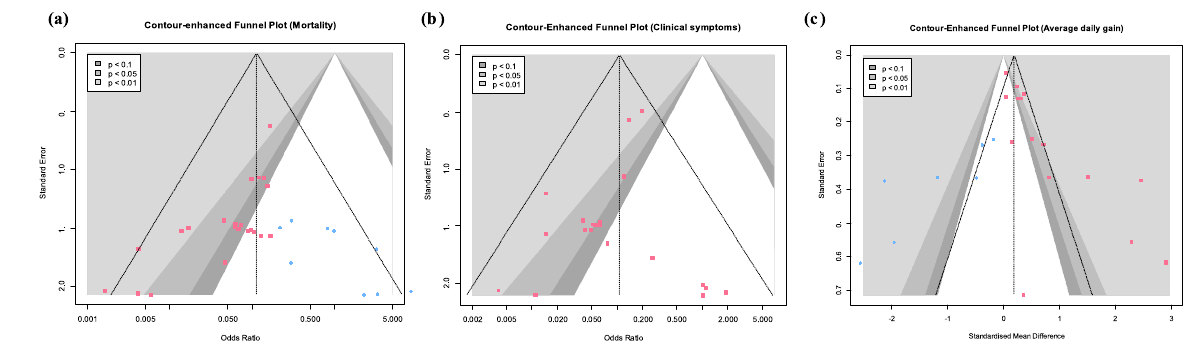
Figure 4. Contour-enhanced funnel plots of eligible studies for each outcome: ( a ) mortality, ( b ) clinical symptoms, and ( c ) average daily gain. Dots represent the individual study, whereas filled red rectangles and filled blue circles represent existing studies and missing studies adjusted by trim-and-fill method, respectively. The statistical program R (version 4.1.1) was used to prepare this figure 44